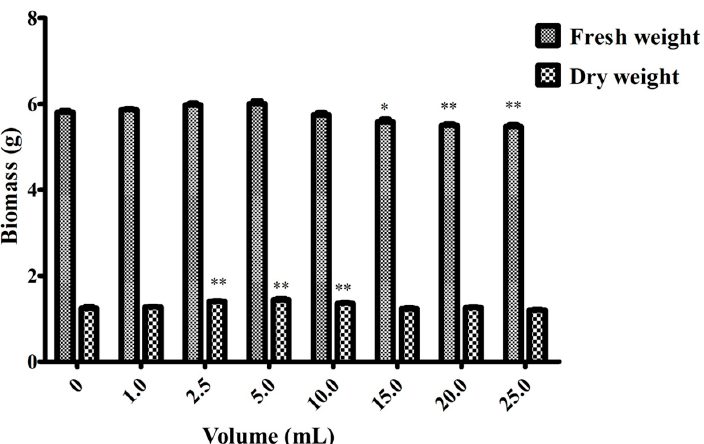
Figure 4. Effects of different endophyte suspension inoculation volumes on biomass after 12 days of flask culture. Data represent the mean ± standard deviation of three replicates. * Significantly different values between the treatment and control groups at p < 0.05. ** Very significantly different values between the treatment and control groups at p < 0.01.